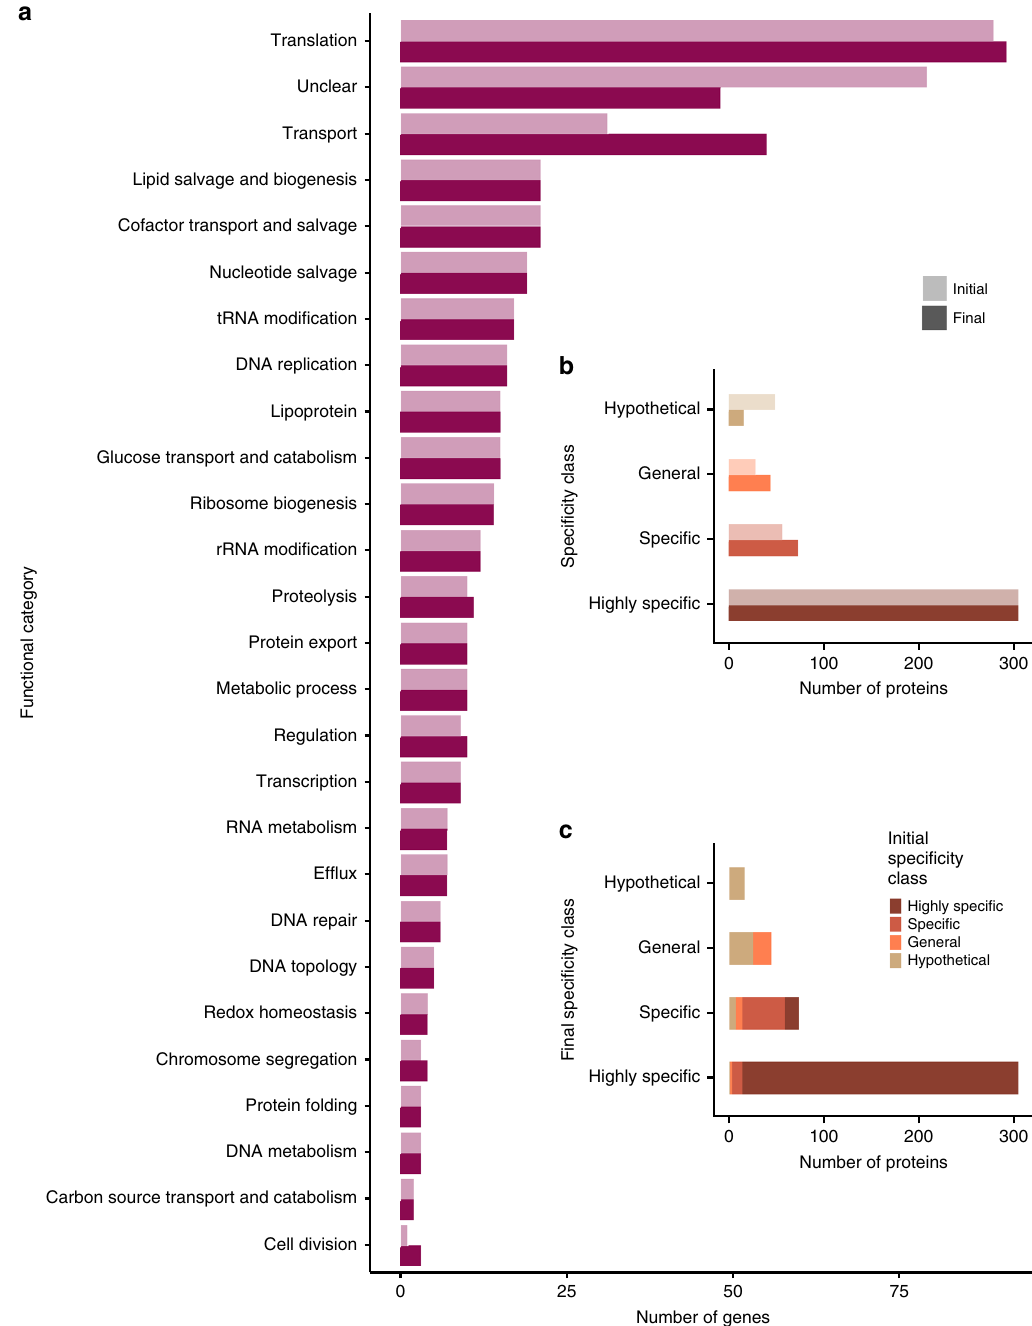
Fig. 8 Functional annotations of the minimal bacterial genome. The number of proteins in each of the a protein biological process categories (light and dark purple indicate initial and fi nal categories, respectively). b Speci fi city classes is shown with the original minimal genome annotation and the annotations identi fi ed here. c Shows the change in speci fi city classes, coloured based on the original speci fi city class. Results for each initial speci fi city class are represented by a different colour: beige for the Hypothetical speci fi city class, orange – General, light brown – Speci fi c and dark brown – Highly speci fi